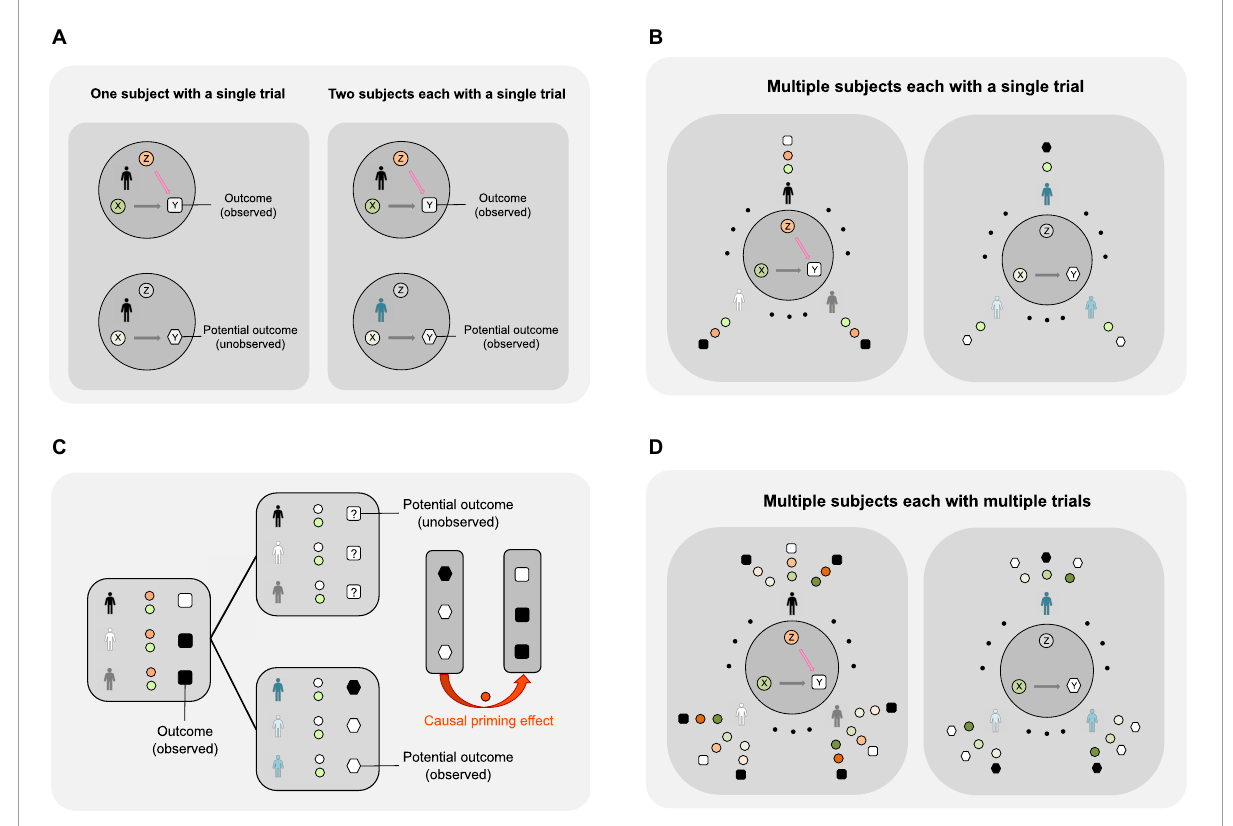
FIGURE2 Using the potential outcomes framework to study the causal priming effect during a word completion experiment. (A) Identifying the causal priming effect with one trial. Top left: The figure describes a scenario where the subject first conducts a word study ( Z = 1) and then aims to identify a target word based on a partial cue (X). The outcome (or Y) is observable. Bottom left: The figure describes a scenario where a subject does not conduct a word study ( Z = 0) and aims to identify a target word based on a partial cue (X). If the subject has already participated in a word study, this (potential) outcome (or Y) under no word study is not observable. Top right: The same experiment as in the top left. Bottom right : Since the potential outcome of the subject (indicated by a human icon in black) is not observable, a different subject (indicated by a human icon in blue) is asked to identify the same target word based on the same partial cue (X), without a word study ( Z = 0). If the two subjects are similar, then the causal priming effect is estimated by the difference between the outcomes (denoted by a letter Y in a square and a letter Y in a hexagon). (B) To reduce the possibility that a particular word may yield various priming effects on different subjects, multiple individuals are randomized to either conduct a word study ( Z = 1) or not ( Z = 0). The individuals with grayscale colors receive a word study; the individuals with bright colors do not receive a word study. For the left image, green circles represent various cues, orange circles represent word studies ( Z = 1), and black or white squares represent the word study outcomes, where a black square indicates success ( Y = 1) and a white square indicates failure ( Y = 0). For the right image, green circles represent the cues corresponding to those on the left image, gray circles with the letter Z refer to having not conducted a word study ( Z = 0), and black or white hexagons represent the word study outcomes, where a black hexagon indicates success ( Y = 1) and a white hexagon indicates failure ( Y = 0). (C) Average priming effect of a word study on word identification among multiple subjects using one trial. Left: Half of the subjects are randomized to perform the word identification experiments after a word study (indicated by orange circles). The black and white squares indicate the observed outcomes. Top middle: The potential outcomes of the same subjects (who have participated in a word study) had they not participated in a word study (indicated by blank circles). The squares with question marks indicate that these outcomes are not observable. Bottom middle: The remaining subjects perform the word identification experiments without a word study; the outcomes are observable and are indicated by black and white hexagons for successful and failed cases, respectively. Right: Due to randomization, the difference in the outcomes between the two groups (divided by the sample size) gives an estimate of the average priming effect of the word study on word identification in a sample. (D) The experiment can be further extended to multiple subjects with multiple words.